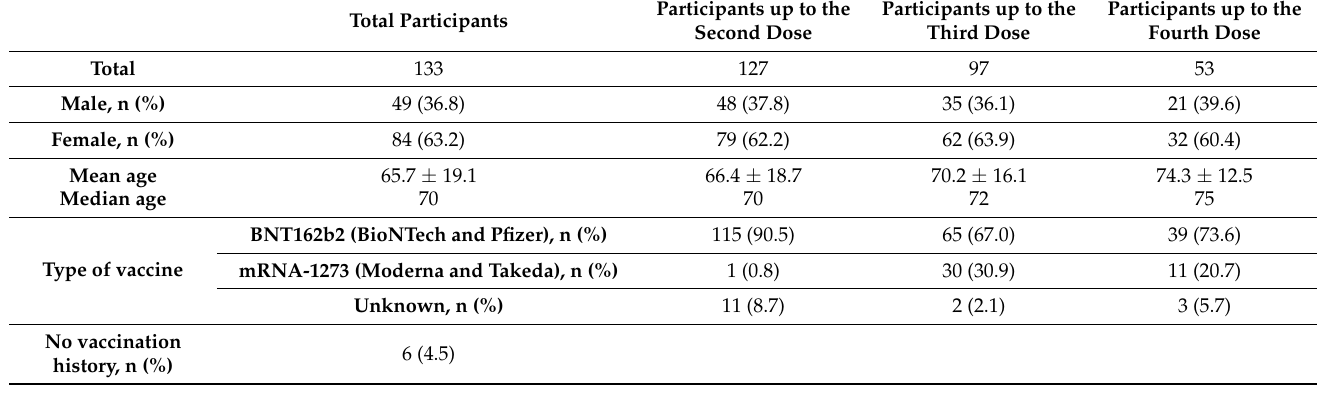
Table 1. Participants’ characteristics up to the second, third, and fourth vaccine doses.